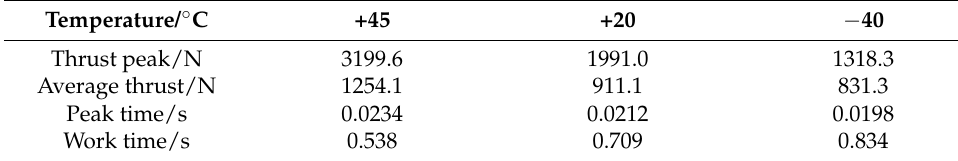
Table 3. Main parameters of parachute.